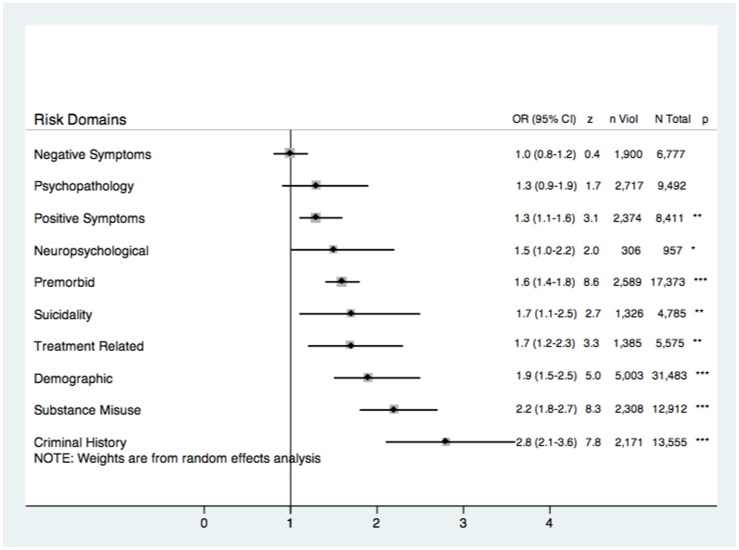
Risk of violence in psychosis reported as odds ratios (ORs) according to ten overall psychosocial and clinical domains for those studies which measured severe violence rather than aggression or hostility (k = 77).
n Violent = number of violent participants, N Total = total number of participants, *** = significant to the <0.001 level, ** = significant to the 0.01 level. * = significant to the 0.05 level. Factors ranked according to pooled OR magnitude.